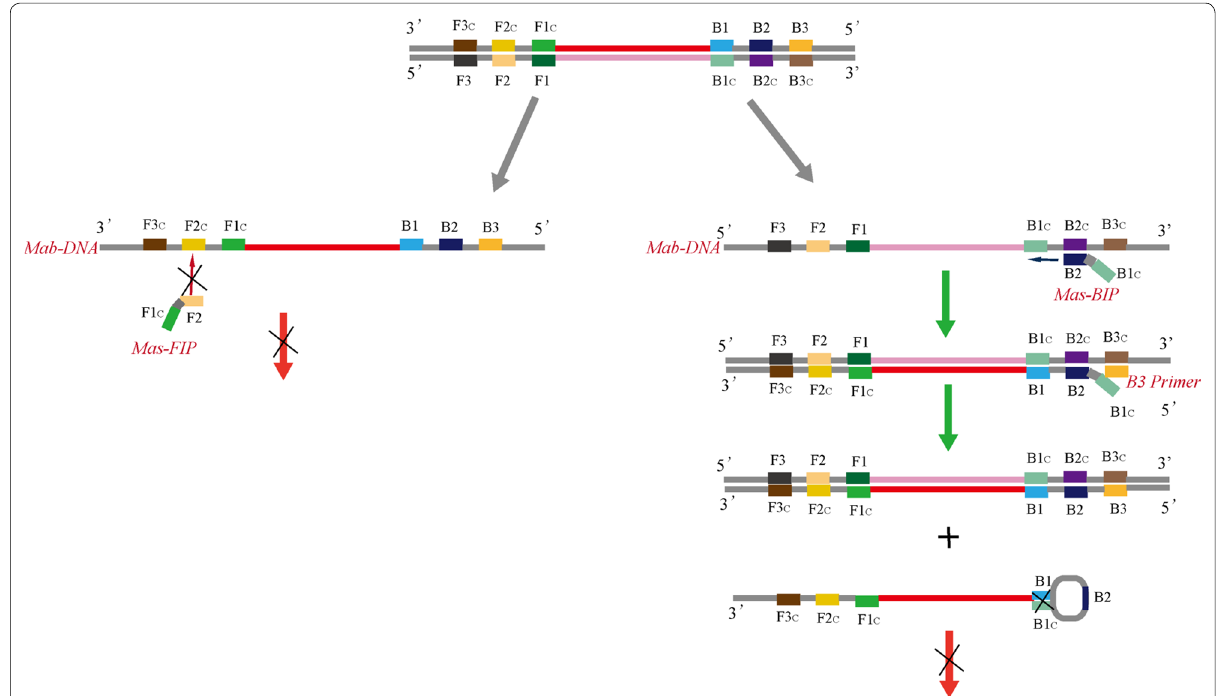
Fig. 2 Schematic diagram of M. massiliense -LAMP primers inability to amplify the M. abscessus erm (41)